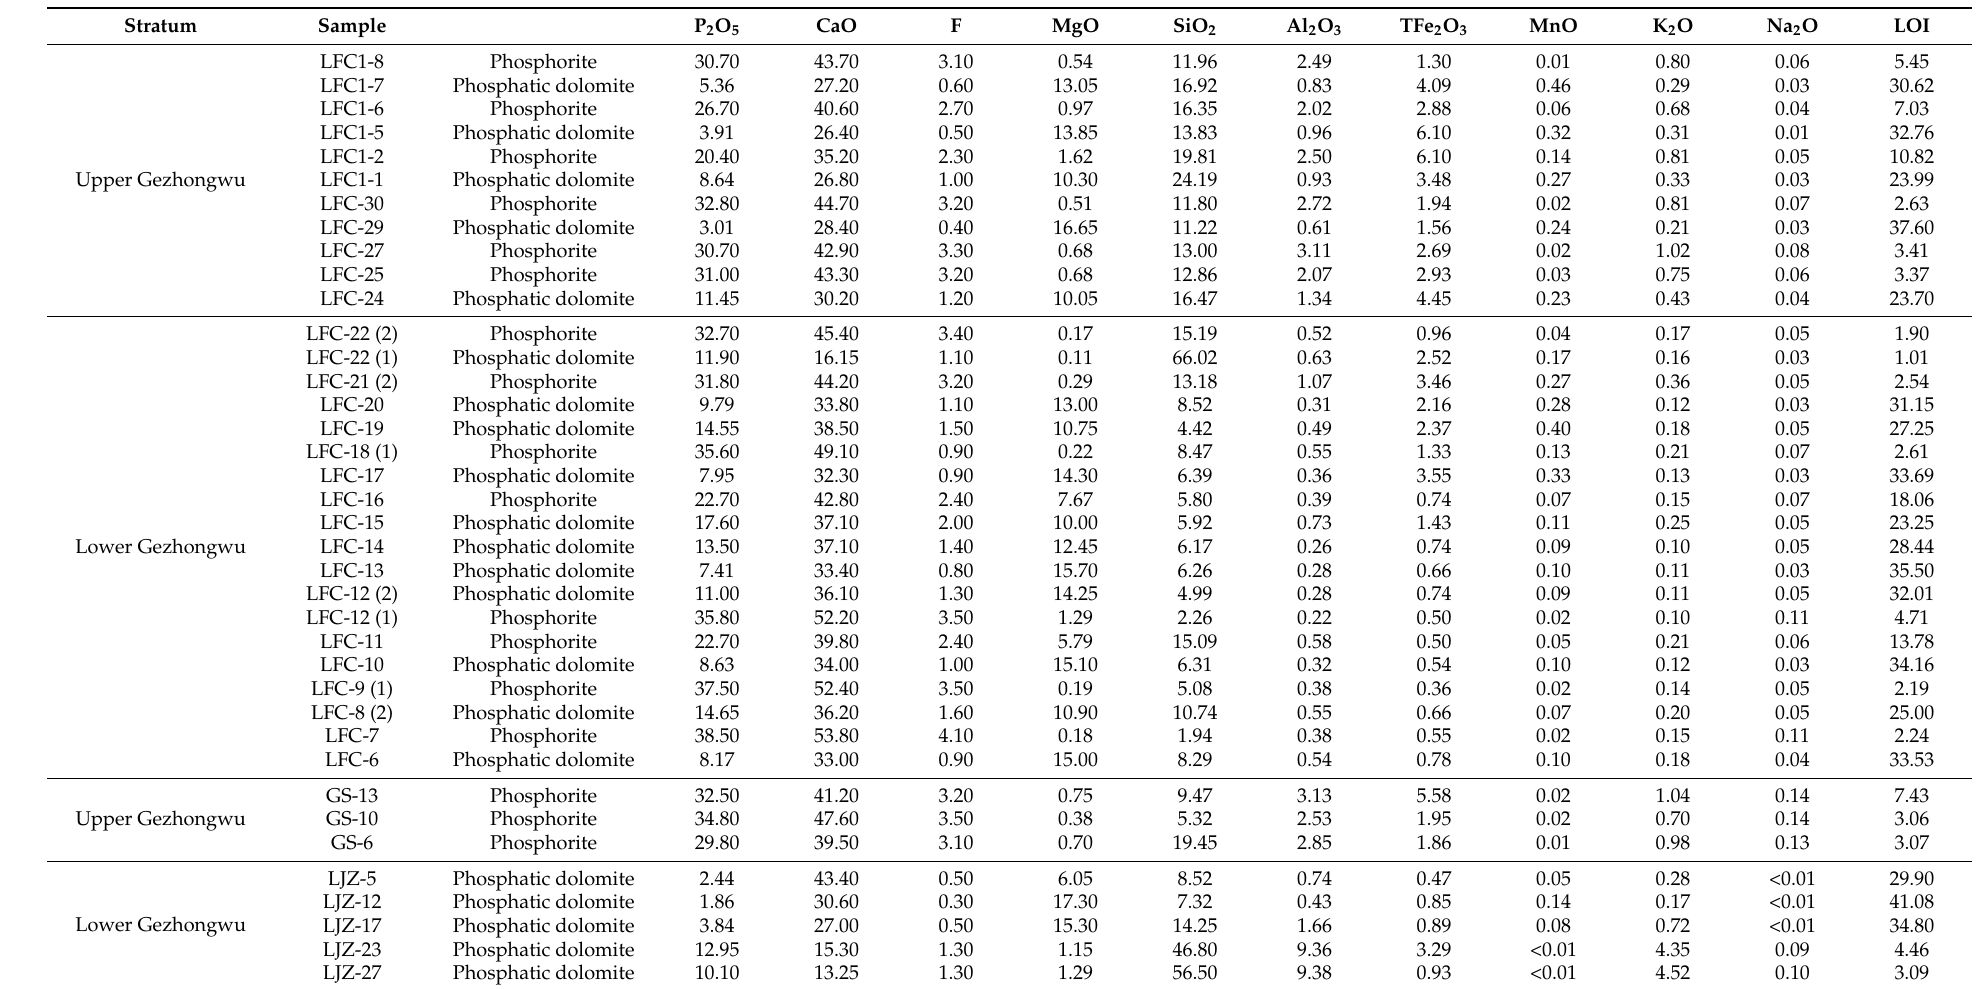
Table 1. Some selected major elements of Zhijin phosphorites